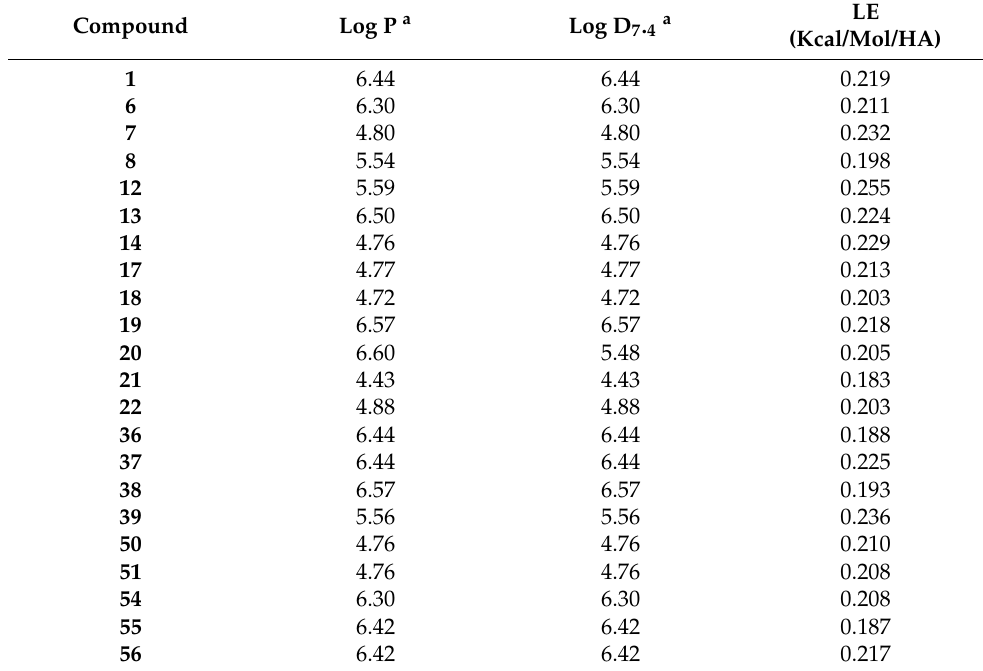
Table 2. Key physicochemical parameters of compounds 1 , 6 – 8 , 12 – 14 , 17 – 22 , 36 – 39 , 50 , 51 and 54 – 56